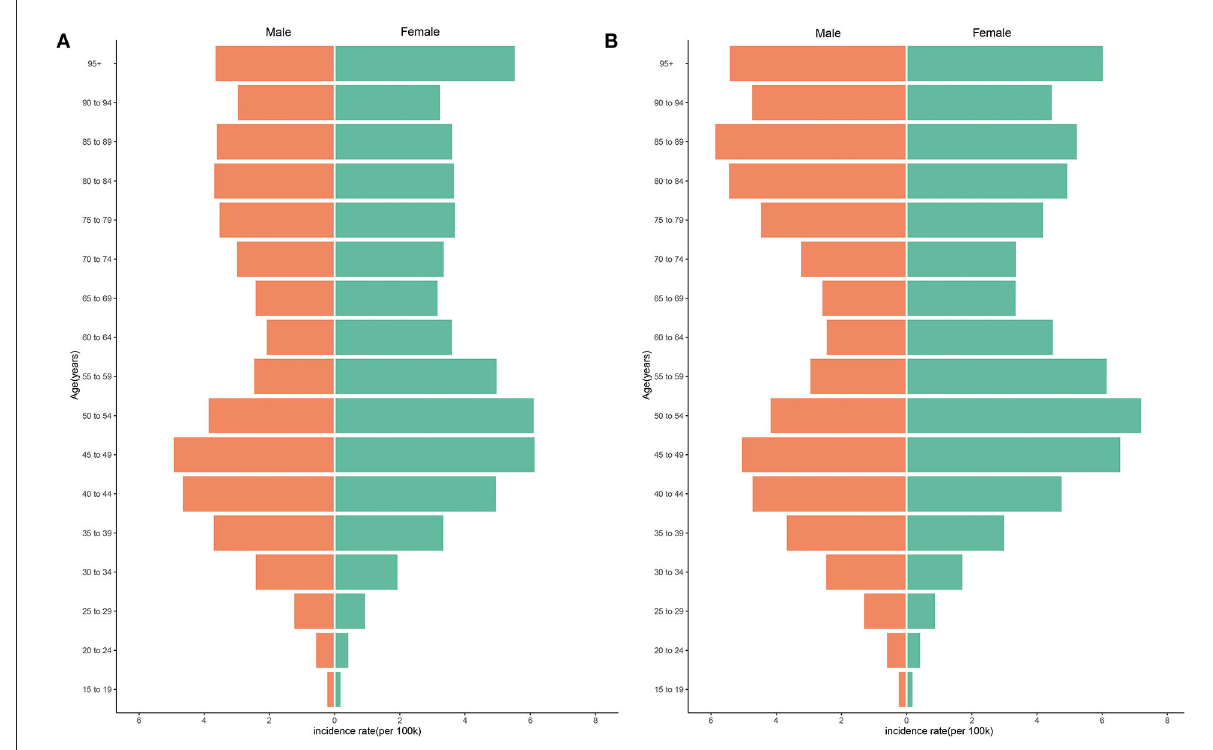
FIGURE1 Difference in ASIR of NAFLD between genders in 1990 and 2019. (A) ASIR in 1990. (B) ASIR in